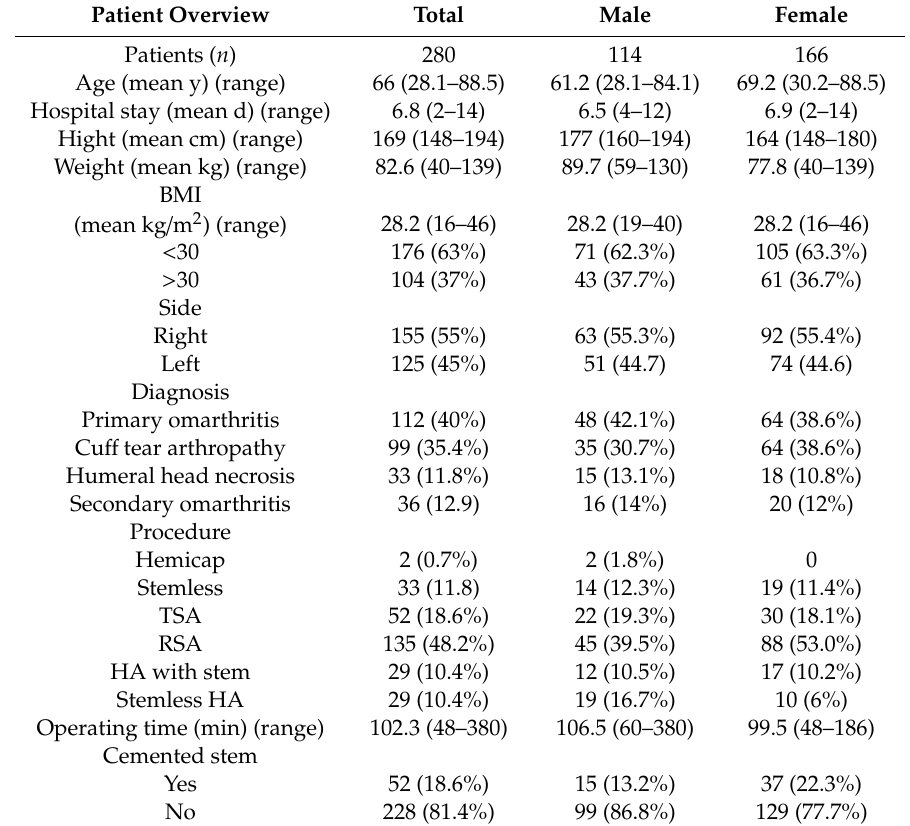
Table 1. Baseline table of the study population presenting the most important demographic findings.